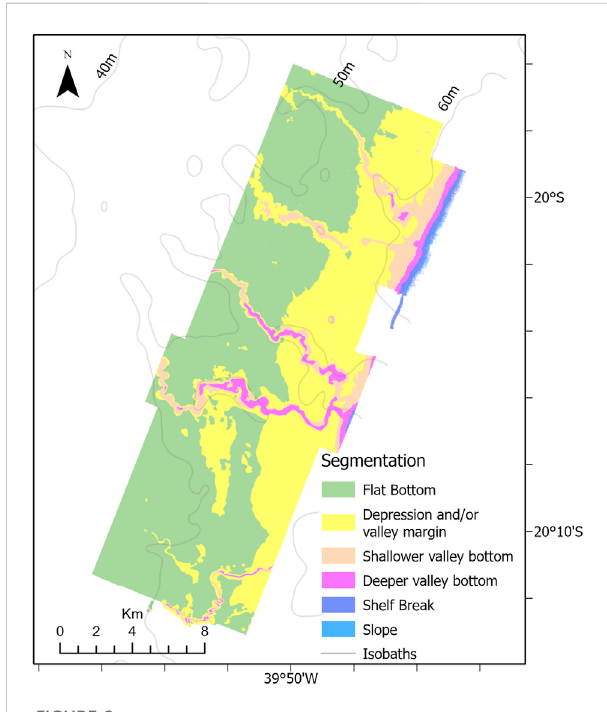
FIGURE 8 Map showing the results from OBIA segmentation. Six distinct classes were de fi ned based on the geomorphometric analysis.